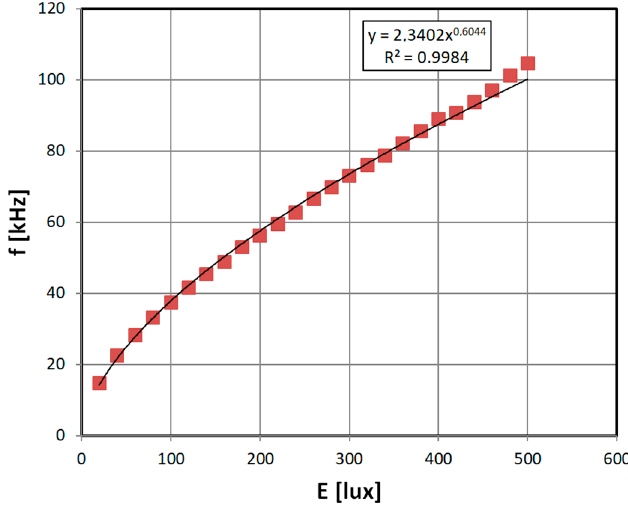
Figure 13. Exemplary results of photoresistor with 555 transducer output characteristic.